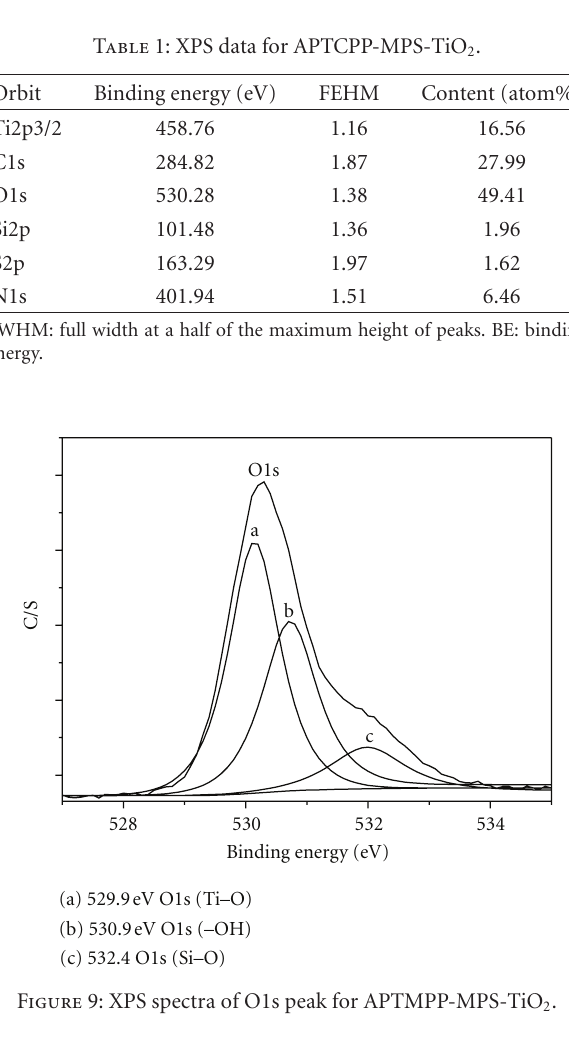
Figure 7: Pore diameter distribution of APTMPP-MPS-TiO 2 .